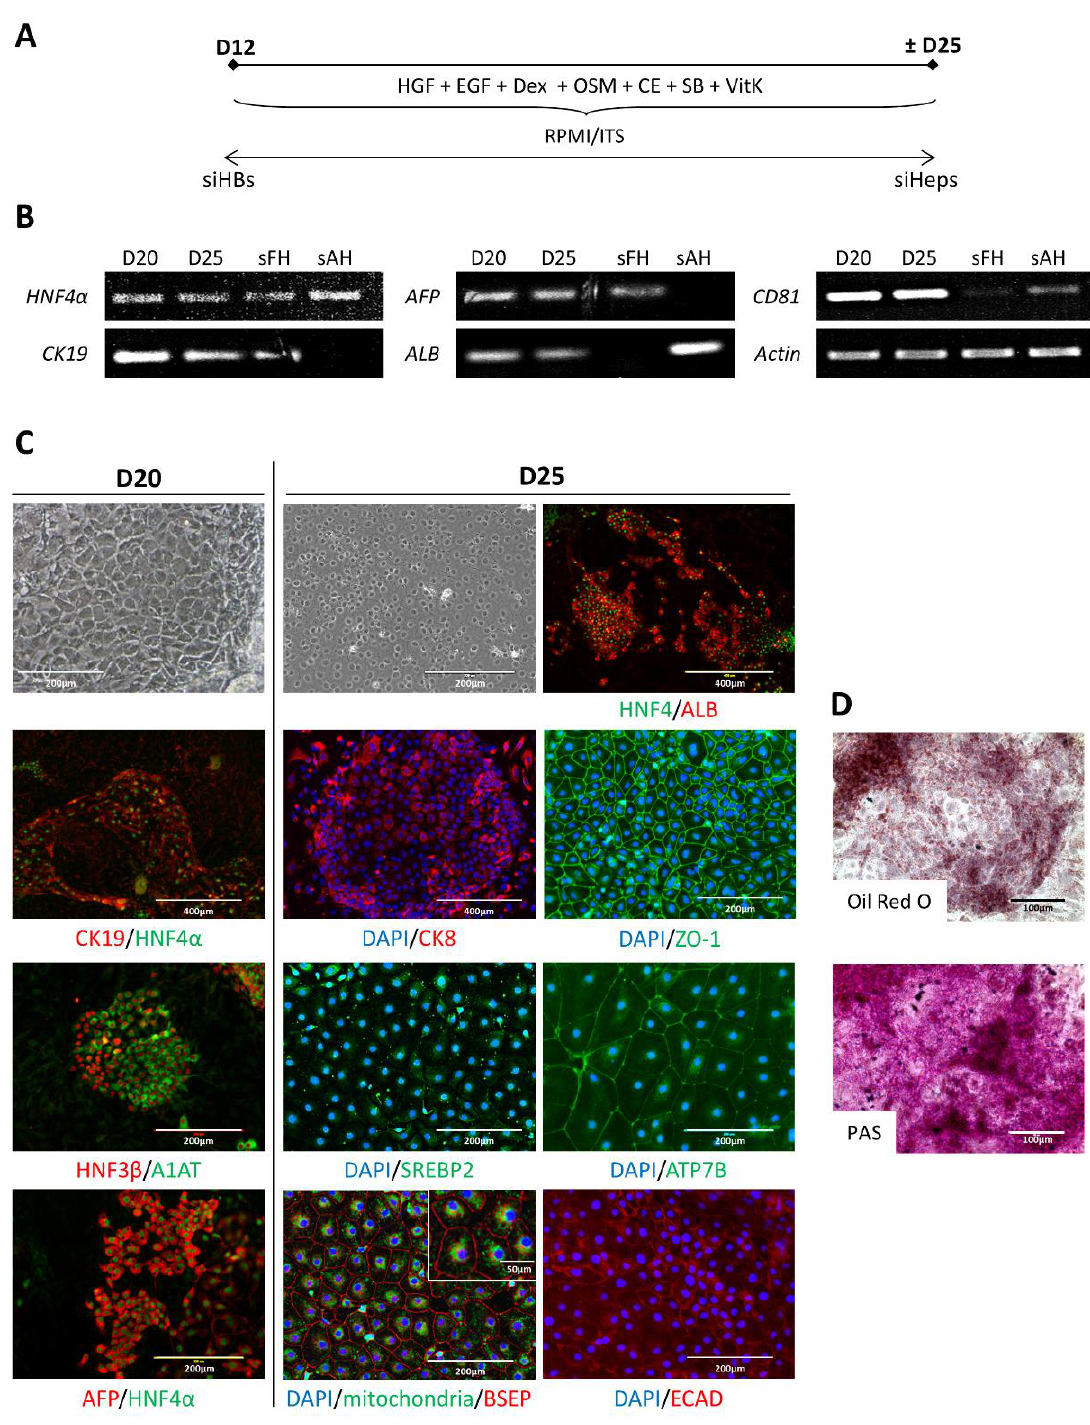
Figure 2. siHB differentiation into siHeps. ( A ) Schematic representation of the differentiation protocol. ( B ) RT-PCR showing the gene expression pattern during siHB differentiation into siHeps. ( C ) Immunostaining showing the expression of hepato-specific markers in siHeps. ( D ) Oil Red O and Periodic Acid Schiff (PAS) stainings of siHeps, evidencing lipid and glycogen storage, respectively. sAH: simian adult hepatocytes; sFH: simian fetal hepatocytes.